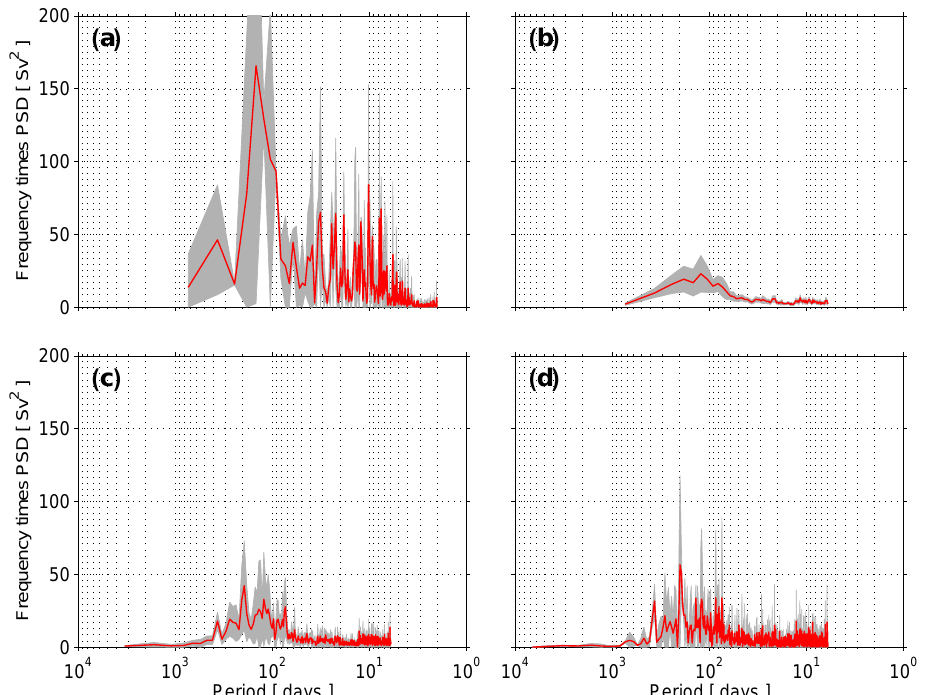
Figure 13. Variance-preserving spectra of the DWBC volume transport time series (integrated from 800 to 4800dbar and between PIES sites A and D). (a) Spectrum for the observational record – as in Fig. 8 but restricting the y axis range for comparison purposes. (b) Spectrum for the DWBC transport calculated from the OFES numerical model output within the same pressure and longitude bounds and utilizing a 2-year window length with 50% window overlap. (c) Same as panel b but using a 9-year window length with 50% window overlap. (d) Same as (b) but using an 18-year window length with 50% window overlap. For all panels the gray shaded region represents the 95% confidence limits for the calculated spectrum. All spectra determined using the Welch’s averaged periodogram method.